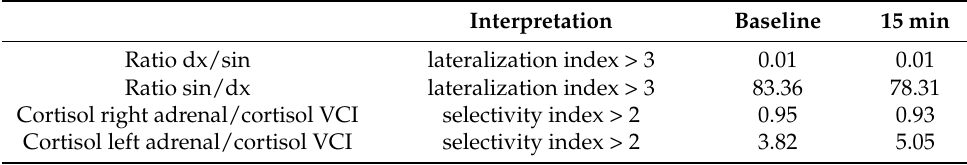
Table 2. AVS results for Case 2.